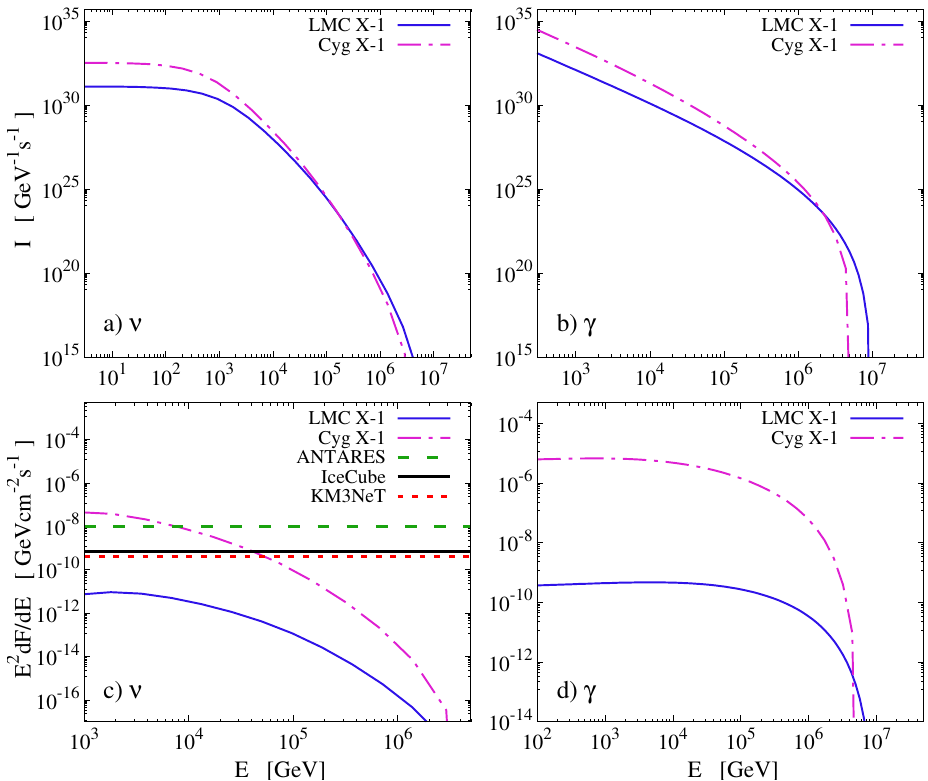
Figure 6. Neutrino ( a , c ) and gamma-ray ( b , d ) intensities and their respective differential fluxes produced by pion ( π ± ) decay taking place at the base of the jet of the binary system LMC X-1 (solid lines), as well as the well-studied system Cygnus X-1 (dashed lines). Additionally, the sensitivities of detectors ANTARES [64], IceCube [65] and KM3NeT [66] are presented in graph c, and the respec- tive sensitivities of MAGIC, HESS, and the foreseen sensitivity of the next-generation Cherenkov Telescope Array (CTA) [67] are also presented in graph d. In graph d, the differential gamma-ray flux points for Cyg X-1, as observed by the MAGIC telescope, are also presented for the sake of comparison with the calculations.